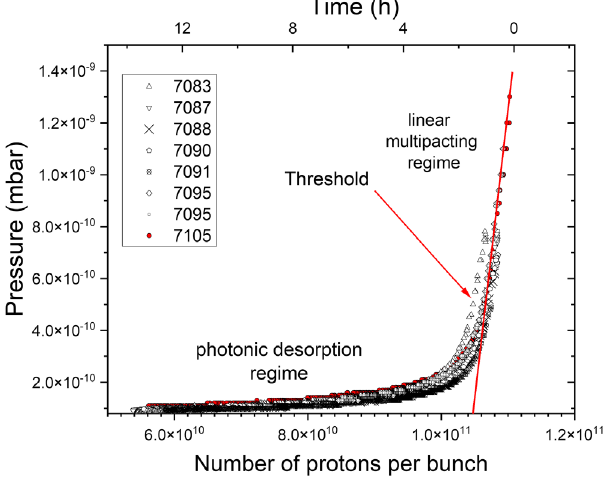
FIG. 7. Variation of pressure with the number of protons per bunch during the p-p collision step with 6 . 5 TeV = beam for several standard physics